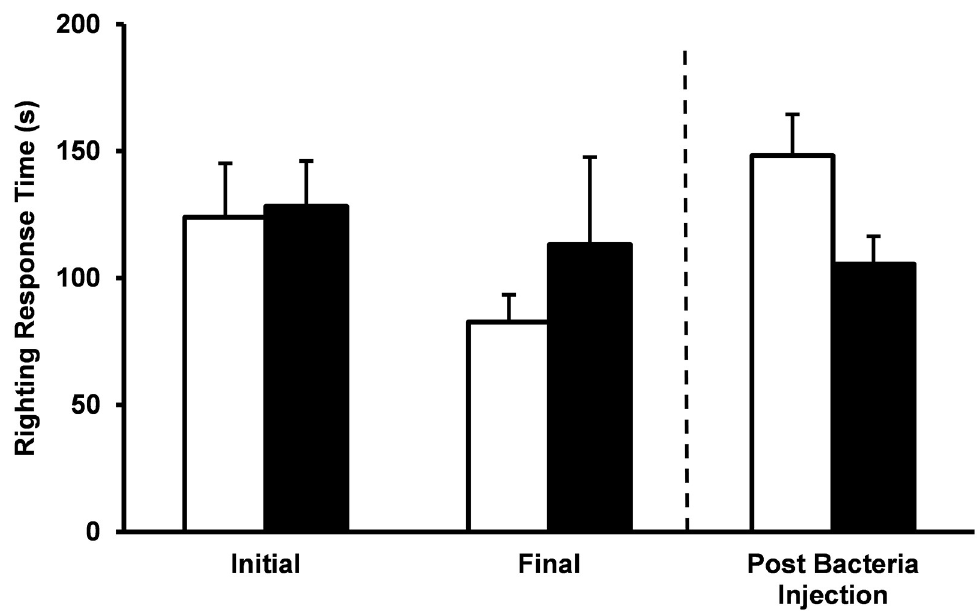
Fig 4. Righting response. Righting time, the time taken to return to upright position following inversion, in fed (white bars) and fasted (black bars) urchins. Righting time was measured initially and 21 days after spine amputation. Following fasting, urchins were injected with Vibrio and righting time measured 2 hours post injection. Mean values ± standard error are shown (n = 9 for each treatment group). Fasting had no significant impact on righting time compared to fed animals ( P > 0.05, ANOVA). There was no difference in righting response time following injection of bacteria between fed and fasted urchins ( P > 0.05, unpaired t-test).